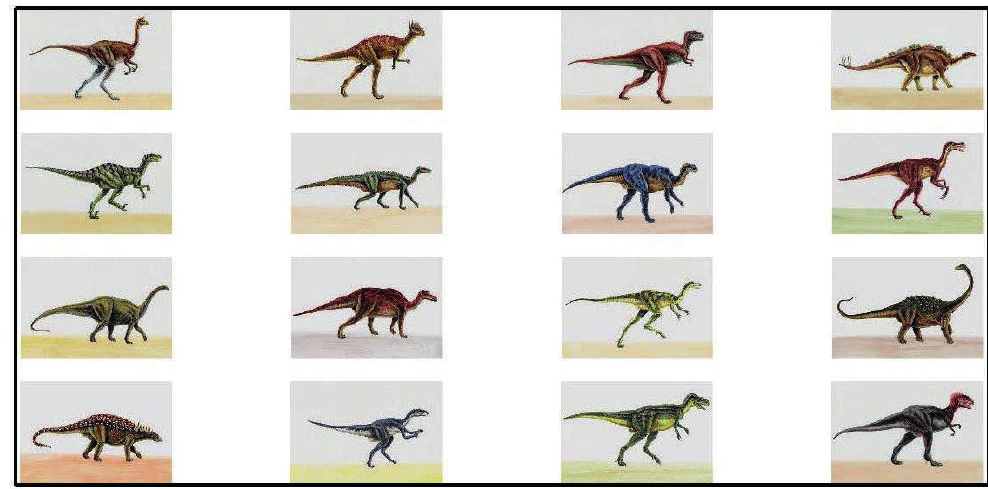
Fig. 13. Dinosaur images retrieved using Framework-3 (EHD-CLD).